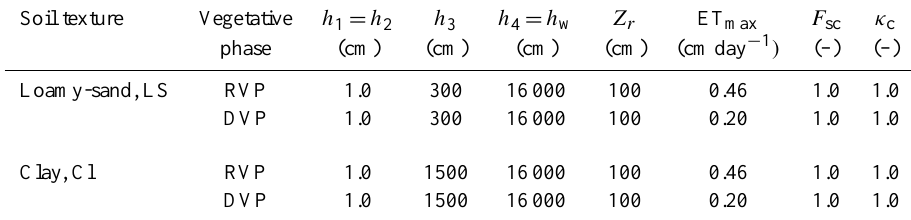
Table 3. SWAP hydrologic parameters.